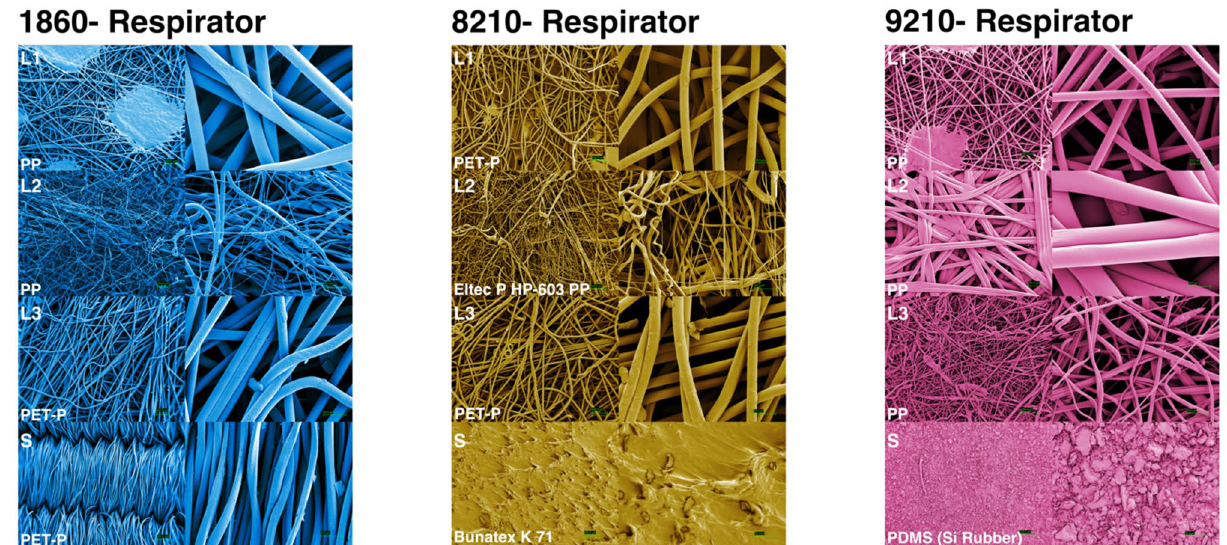
Figure 3. Material characterization summary of the 1860, 8210 and 9210 N95 respirators. The left columns of SEM images for each respirator model are ×55 magnification, and the right columns are ×302 magnification. SEM images are falsely coloured for clarity